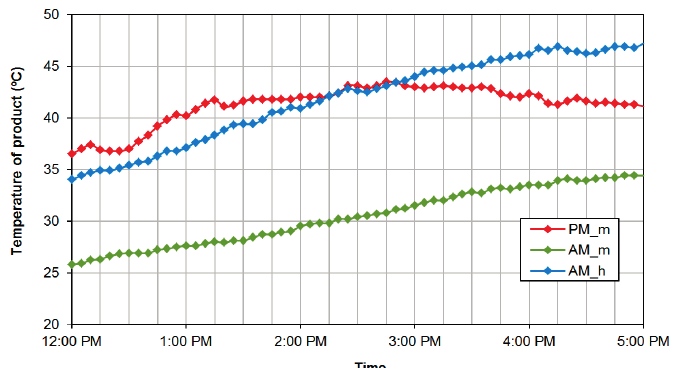
Figure 9. Temperature variation for OMW.